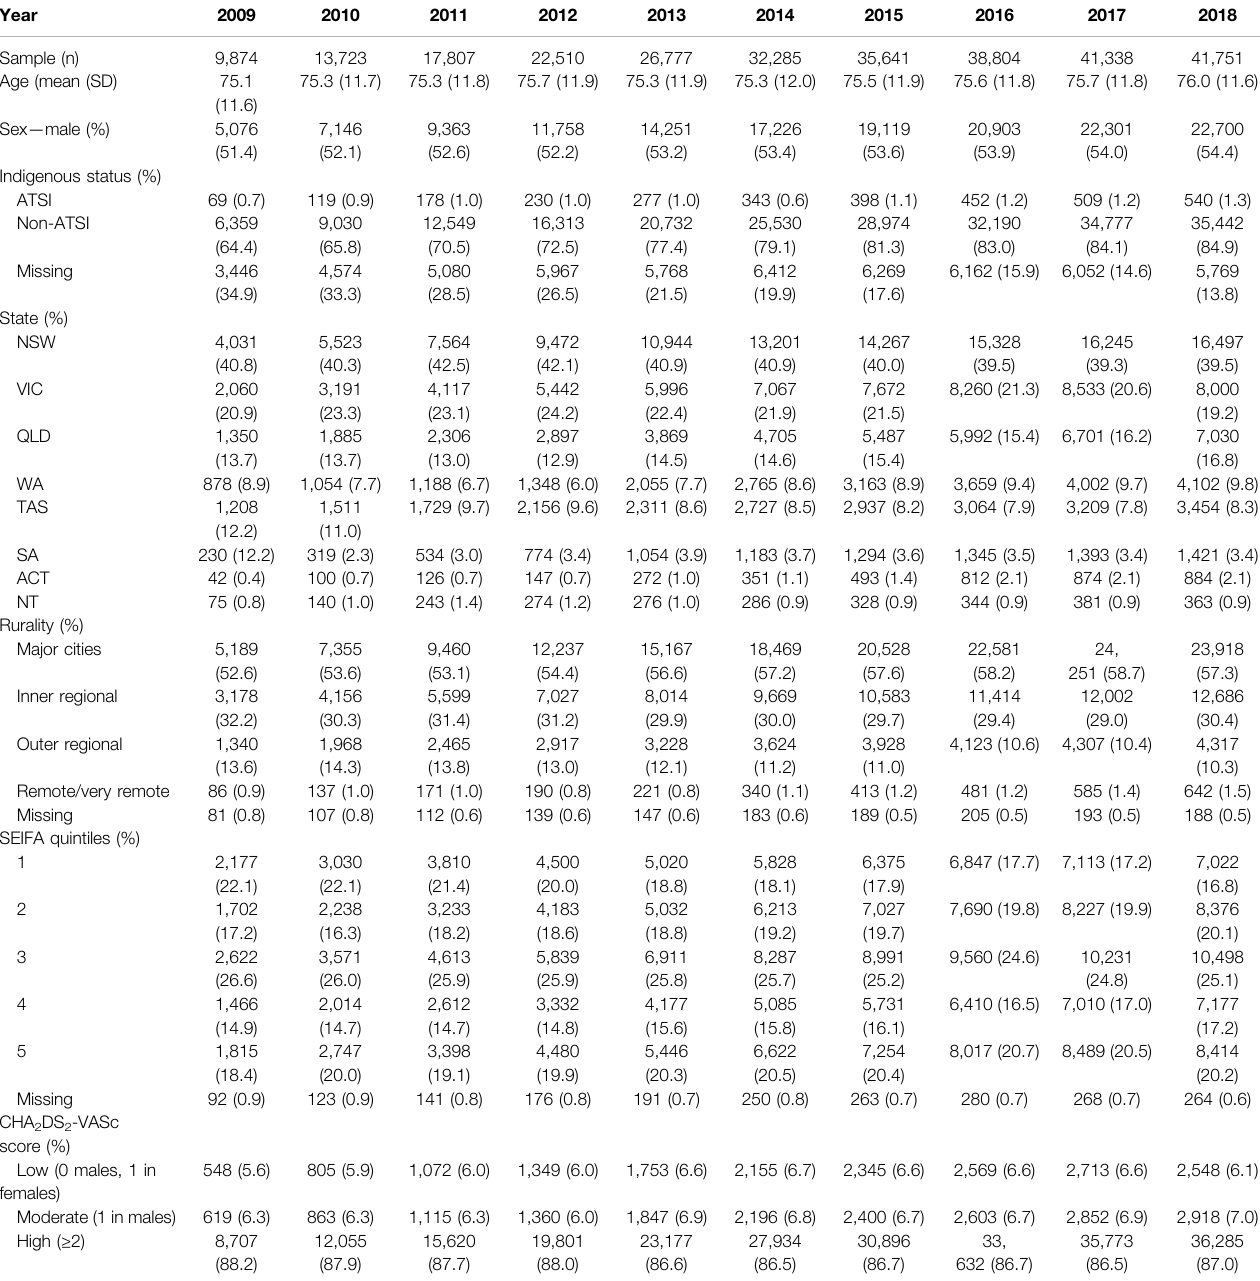
TABLE 1 | Demographic characteristics of patients with atrial fi brillation, 2009 –